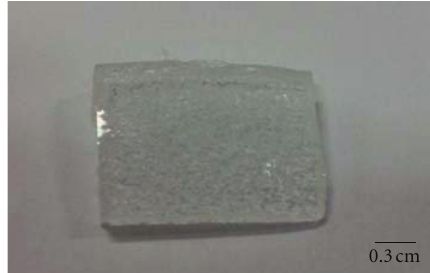
Figure 15: Embedded microlens optical film with no lens structure.